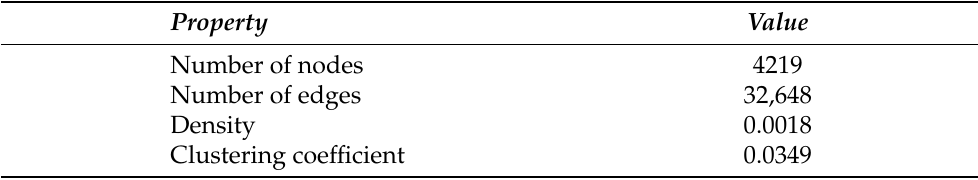
Table 5. Some basic properties of the graph A .